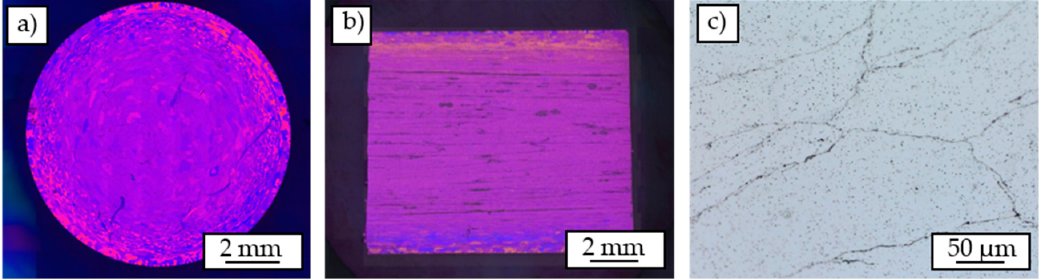
Figure 4. Overview of Barker-etched cross-section ( a ), Barker-etched longitudinal section ( b ), and detailed view of welded chips ( c ).